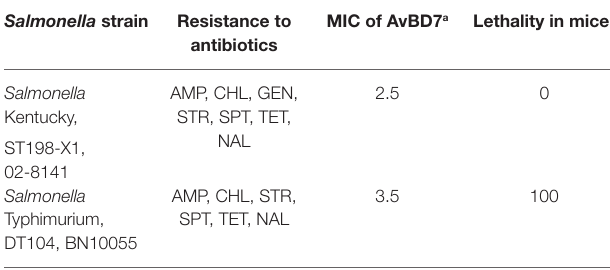
TABLE 1 | Phenotypic characteristics of Salmonella